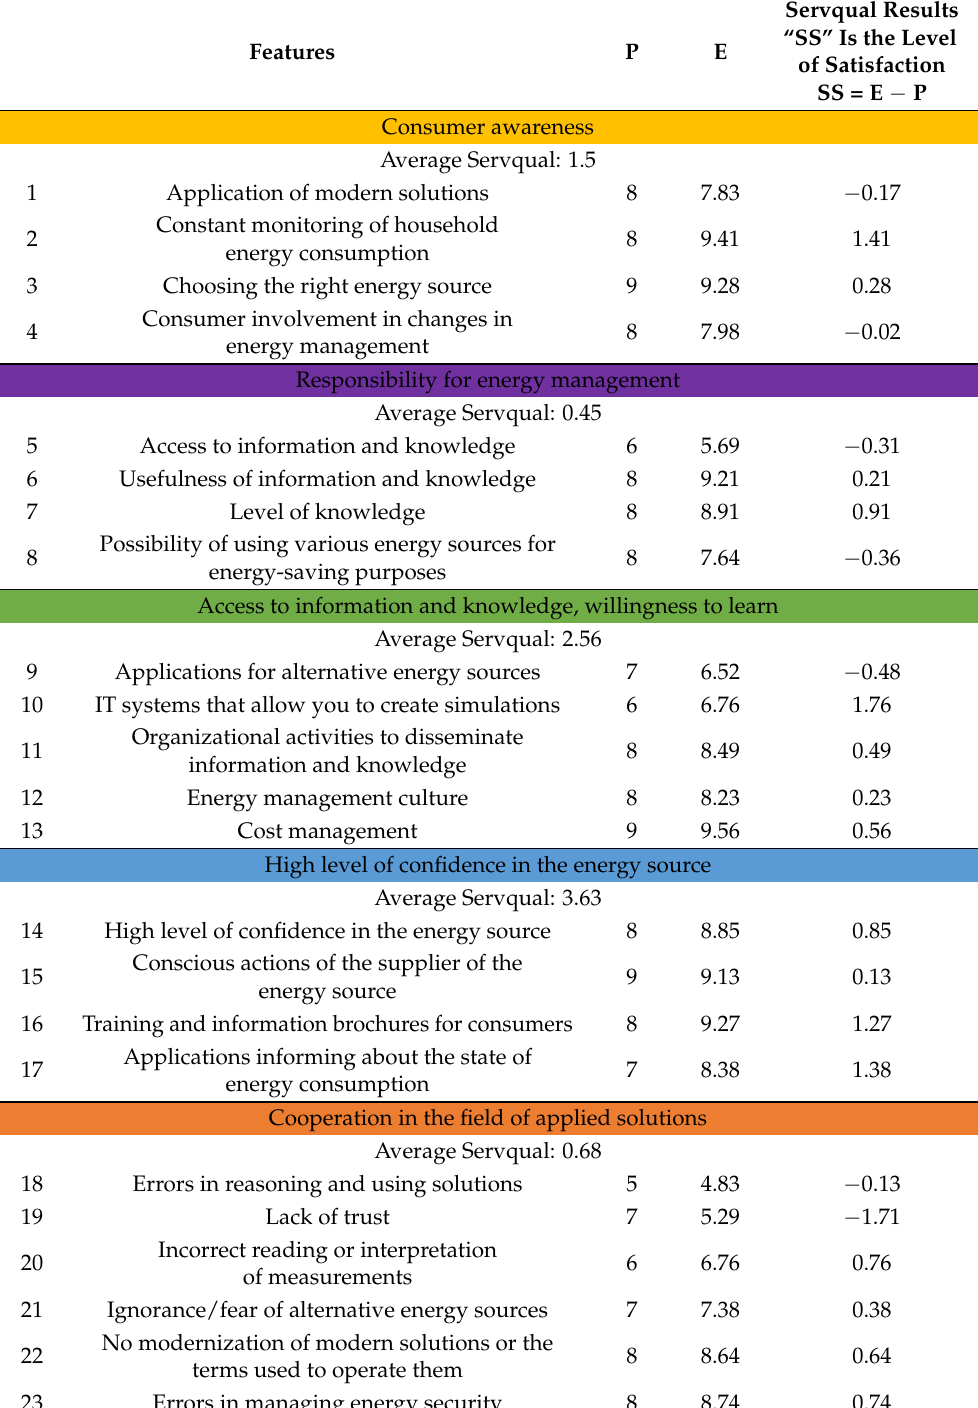
Table 3. Servqual analysis of differences between levels of